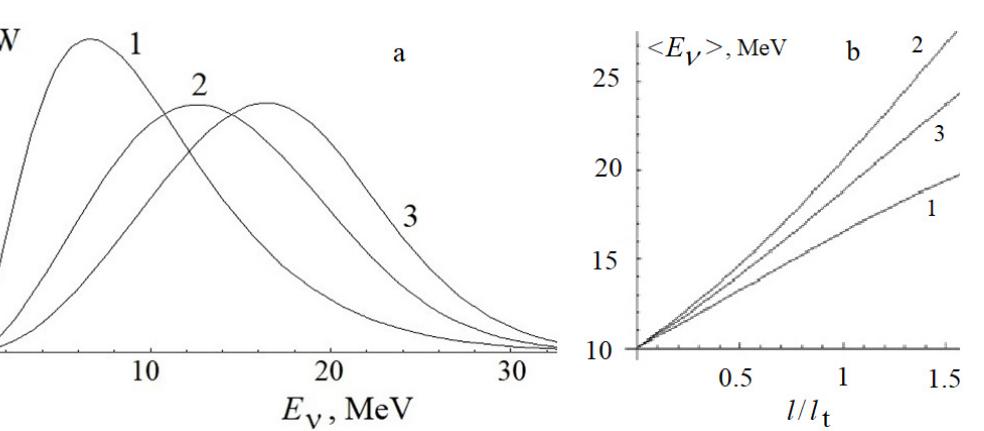
Figure 2. Neutrino energy spectra in arbitrary units for α = 2, E av = 10 MeV, and e l = 1 (i.e., l = 0) — curves 1, 2 — curves 2, and 3 — curves 3 at T = ( a ) 5 MeV ( b ) 10 MeV. The curves 4 correspond to a respective single effective collision event at ∆ = 2 MeV.